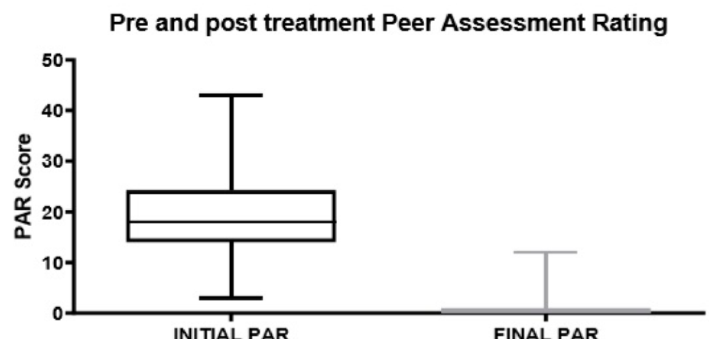
Figure 10. Histogram of pre-treatment and post-treatment PAR